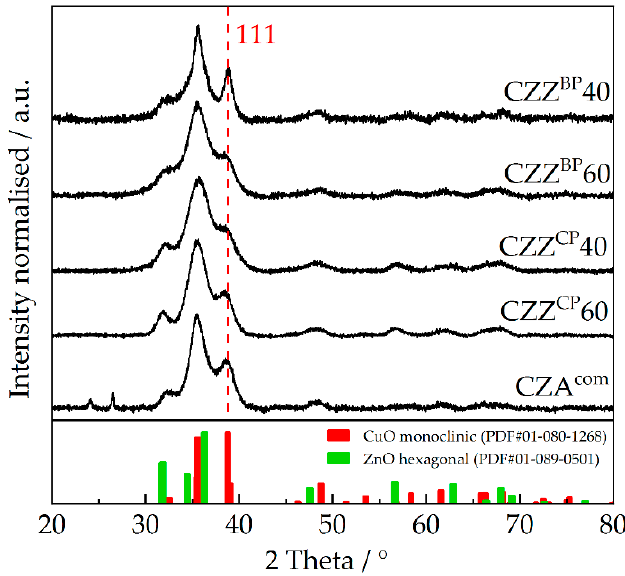
Figure 2. X-ray diffraction patterns of the calcined CZZ pre-catalysts and CZA com (XRD: 5–80 ◦ , 120 min). Figure 2. X ‐ ray diffraction patterns of the calcined CZZ pre ‐ catalysts and CZA com (XRD: 5–80°, 120 min). Table2. EstimatedaverageCuOcrystallitesizesaccordingtoScherrerequationfromXRDmeasurements of the fresh pre-catalysts and the spent catalyst after activity test. Main CuO reflection 2 θ received from deconvolution of XRD pattern using Gauss